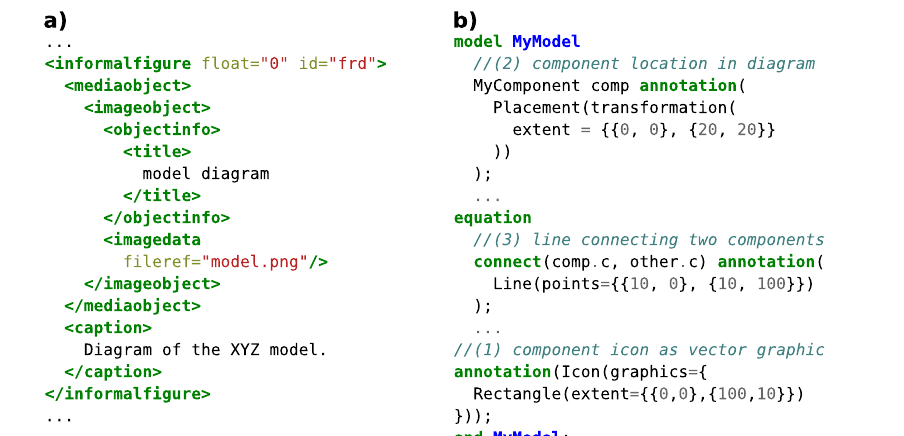
Fig. 4 Two different ways in which modeling languages can support graphical representations of models as part of their syntax. a CellML allows to include diagrams or plots as fi gures in the model documentation. The image fi les remain separate from the model code and have no semantic connection to it except for the fi gure caption. b Modelica allows to add graphical annotations using a vector graphics syntax. Models and their components can have icons graphics ( //(1) ), which can be placed in a diagram coordinate system ( //(2) ) and connected with lines ( //(3) ). This graphical representation is tied to the structure of the model. If, e.g., a component is removed from a model, the placement annotation ( //(2) ) must also be removed, which automatically updates the diagram and ensures that it still accurately re fl ects the new model